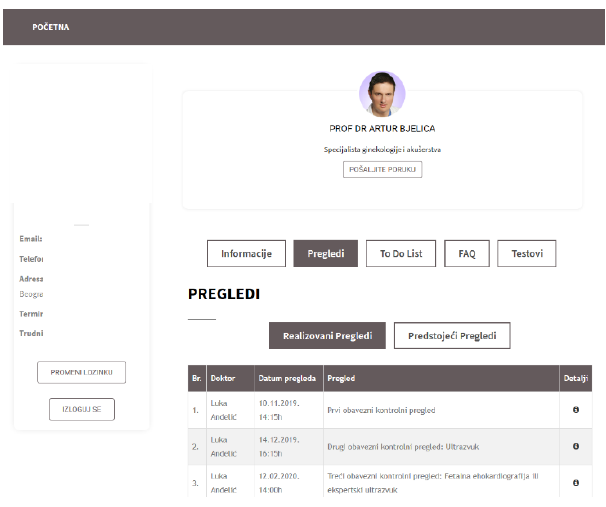
Figure 5. Web application — pregnant woman dashboard.